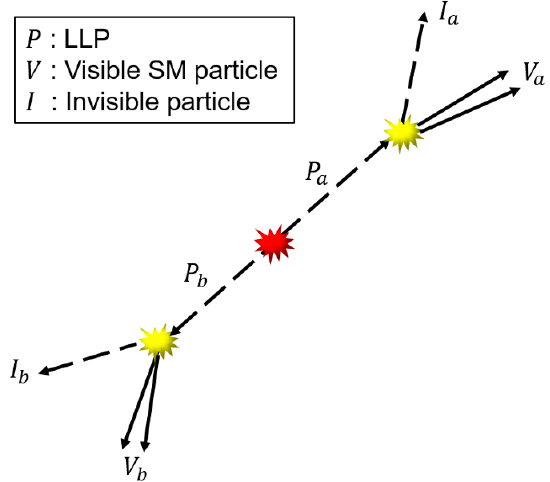
Figure 2 . Typical event topology for the LLP pair-production with decays to visible and invisible